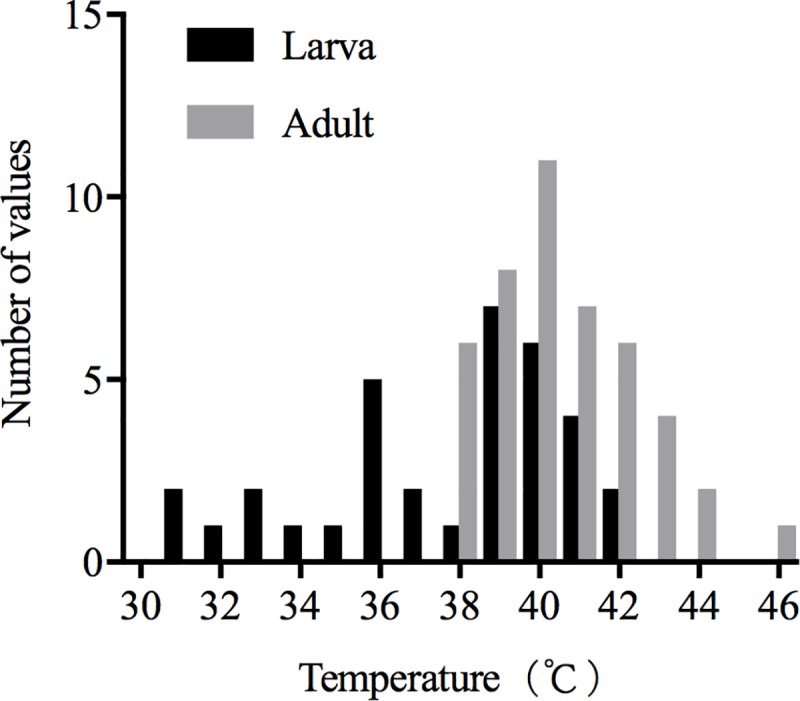
Frequency distribution of CTmax of S. noctilio.The grey column represents the number of adults died between the range on the X Axis, and the black column represents the same content of the larva (P < 0.0001 in Mann-Whitney test).